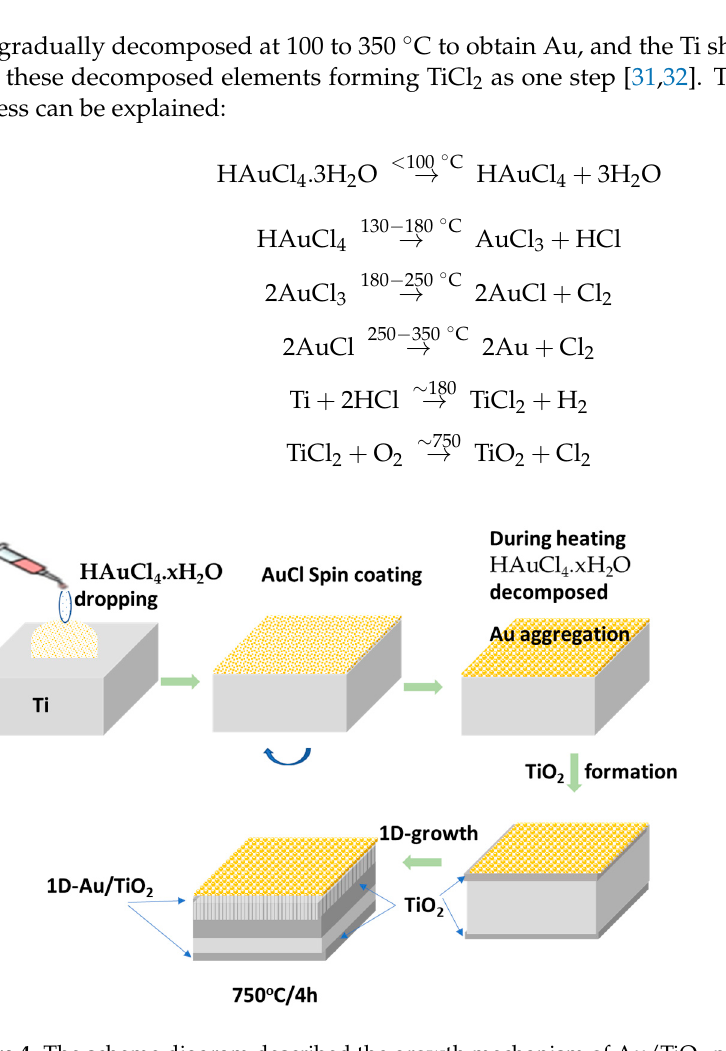
Figure 5. ( a ) CV curves measured at a scan rate of 50 mVs − 1 for pure TiO 2 , Au1/TiO 2 , and Au2/TiO 2 samples and ( b ) GCD curves measured at a current density of 5 µAcm − 2 .